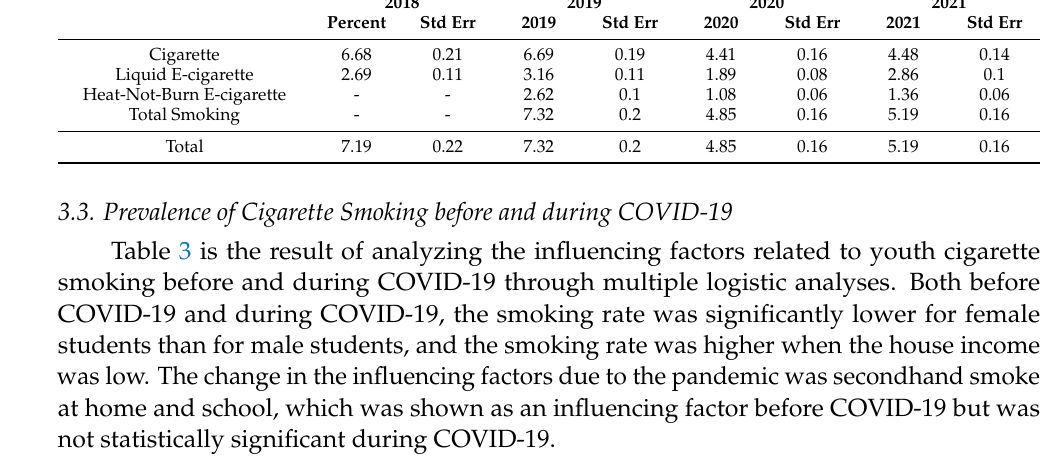
Table 3. Prevalence of Cigarette’s Smoking Before and During